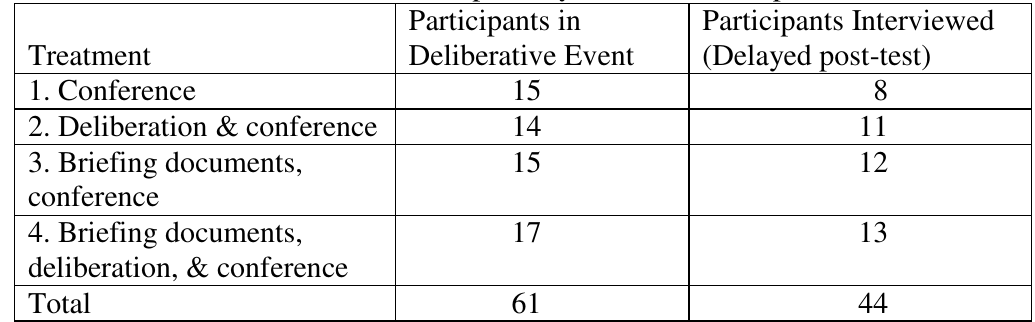
Table 1. Number of Interview Participants by Treatment Group